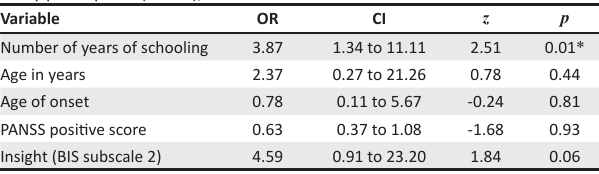
PANSS, positive and negative syndrome scale; BIS, Birchwood insight scale; OR, odds ratio; CI, confidence interval. * , Statistical significance at p < 0.05.